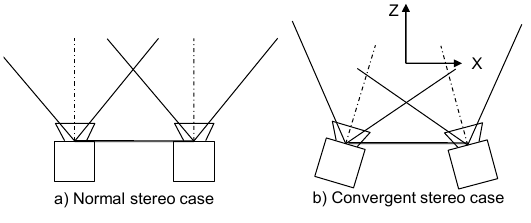
Figure 11: Stereo camera scenarios For an observed sphere, Figure 12 shows the principle effect of eccentricity on the calculated 3D point coordinates. Here the effect in x is illustrated because it is most critical for the x- parallax, hence for depth calculation. For cameras that are configured according to the normal case of stereophotogrammetry (Figure 11a), ex ' and ex " have the same sign, hence the resulting X- or Y-coordinate is shifted while Z is almost unaffected. In contrast, for convergent imagery (Figure 11b) the sign of eccentricities is different, and a systematic x-parallax error occurs that results in an object error mainly in Z.